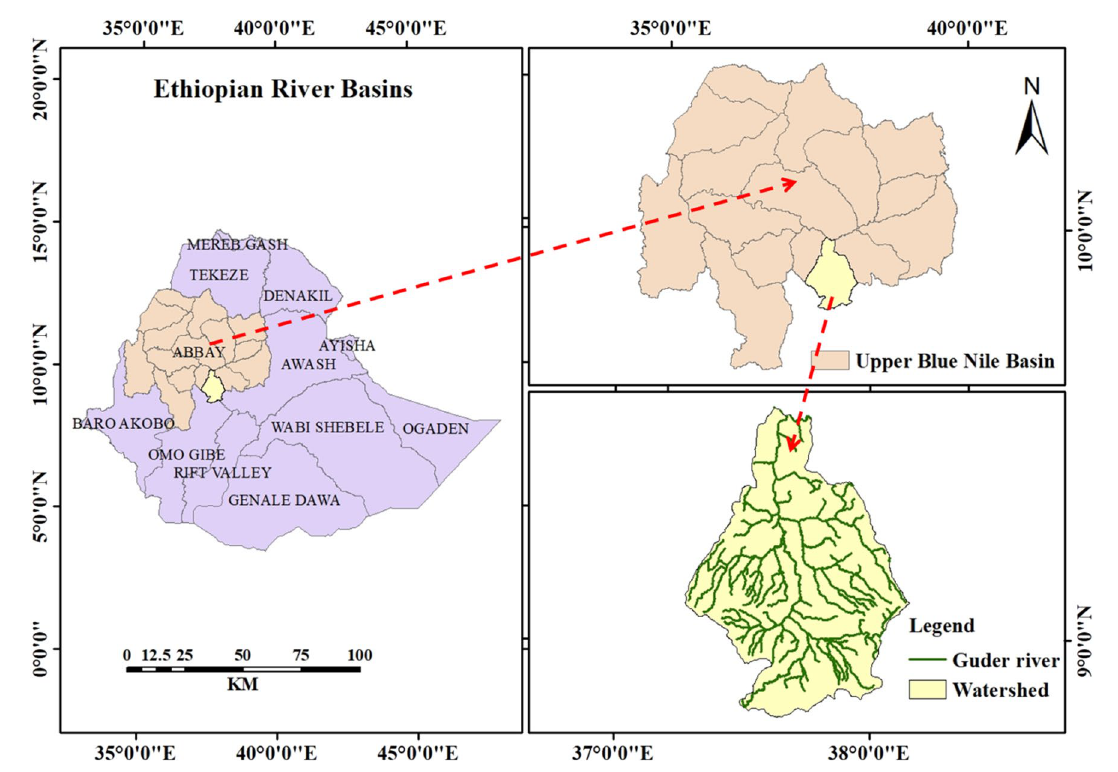
Fig. 1 Map of the study area (Haile